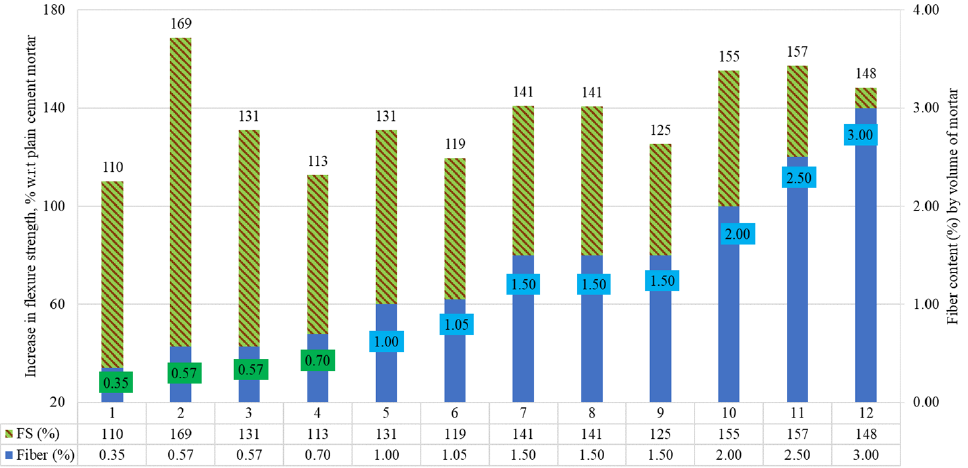
Figure 18. Percentage comparison of the flexure strength of RSF mortars encompassing RSF by volume fraction.